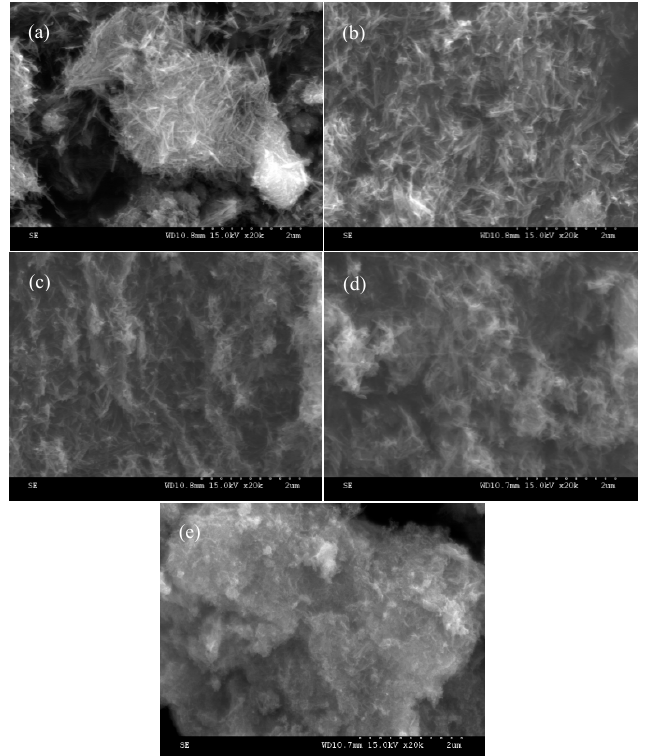
Figure 3. SEM images of ( a ) OMS-2, ( b ) 1Cu/OMS-2, ( c ) 5Cu/OMS-2, ( d ) 15Cu/OMS-2, and ( e ) 20Cu/OMS-2.